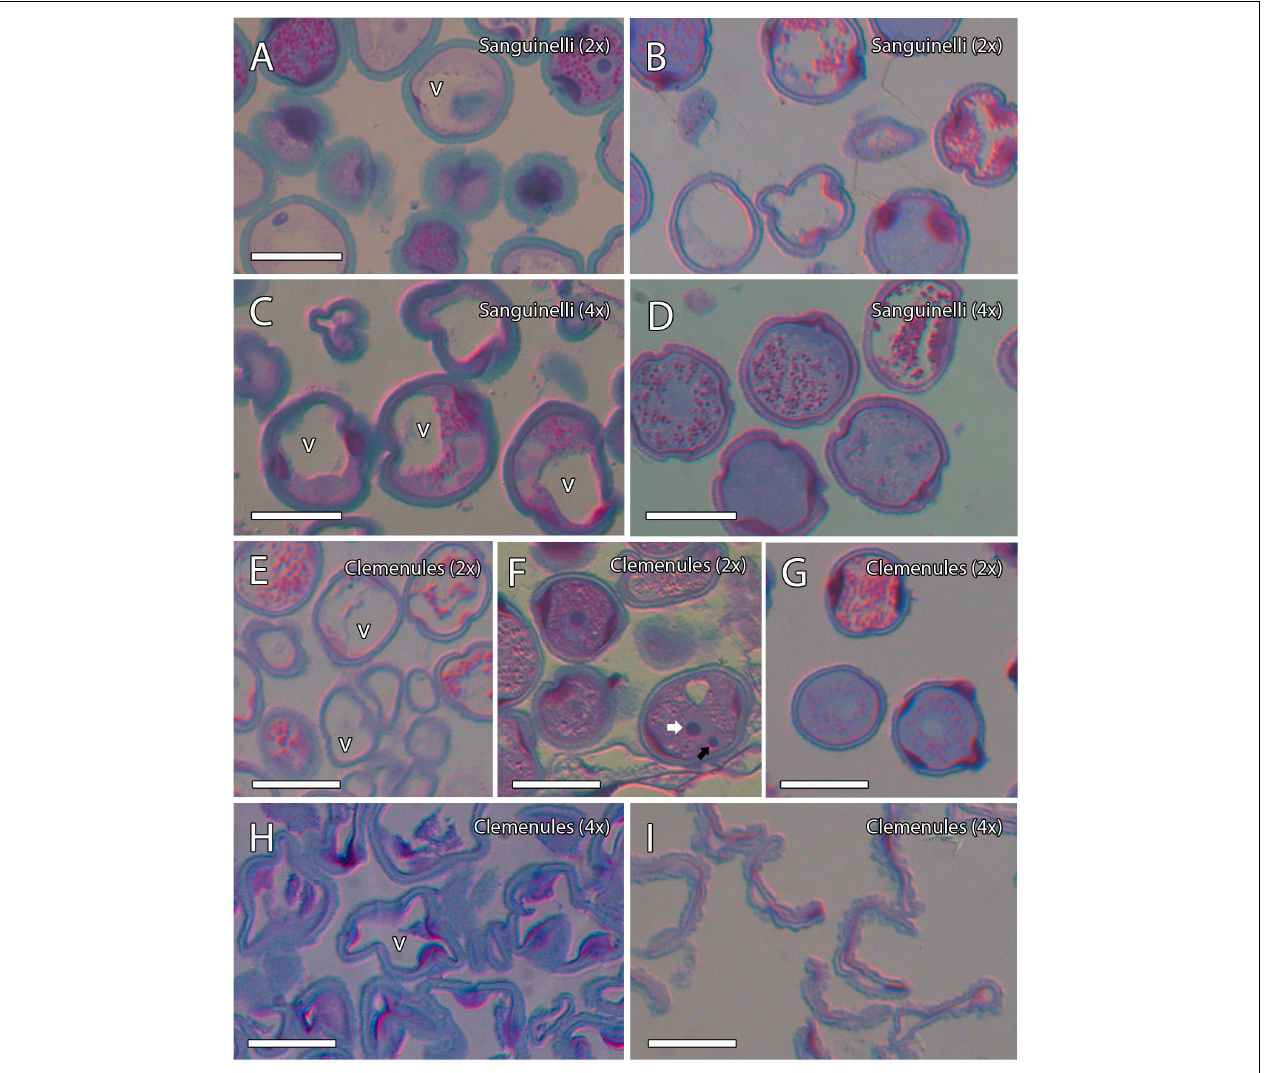
FIGURE 8 | Microgametogenesis of diploid and doubled diploid “Sanguinelli” blood orange and “Clemenules” clementine. Sections were stained with periodic acid-Schiff reagent (PAS) and toluidine blue. (A,C,E,F) Starch accumulation (grains in pink color) in vacuolate microspores and concomitant mitosis I in (A) diploid “Sanguinelli” and (E,F) “Clemenules“ and (C) doubled diploid “Sanguinelli”. (F) Pollen grain showing central vegetative nucleus (white arrow) and lateral generative nucleus (black arrow) in diploid “Clemenules” clementine. (H) Starch grains were not observed in vacuolate microspores in doubled diploid “Clemenules”. (B,D,G) Diploid “Sanguinelli” (B) and “Clemenules” (G) and doubled diploid “Sanguinelli” (D) show starch-less and starch-containing pollen grains at anthesis. (I) Doubled diploid “Clemenules” clementine shows pollen grains without starch grains and shrinkage at anthesis. All scale bars = 25 µ m. Diploid (2x), doubled diploid (4x), and vacuole